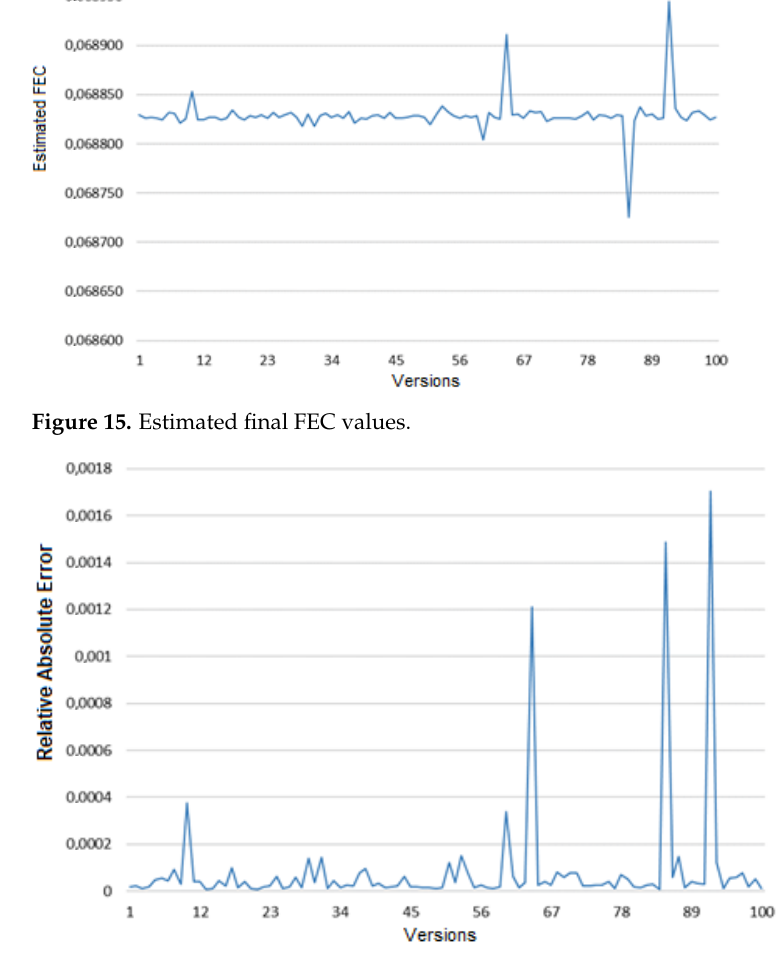
Figure 16. Relative absolute error FEC.